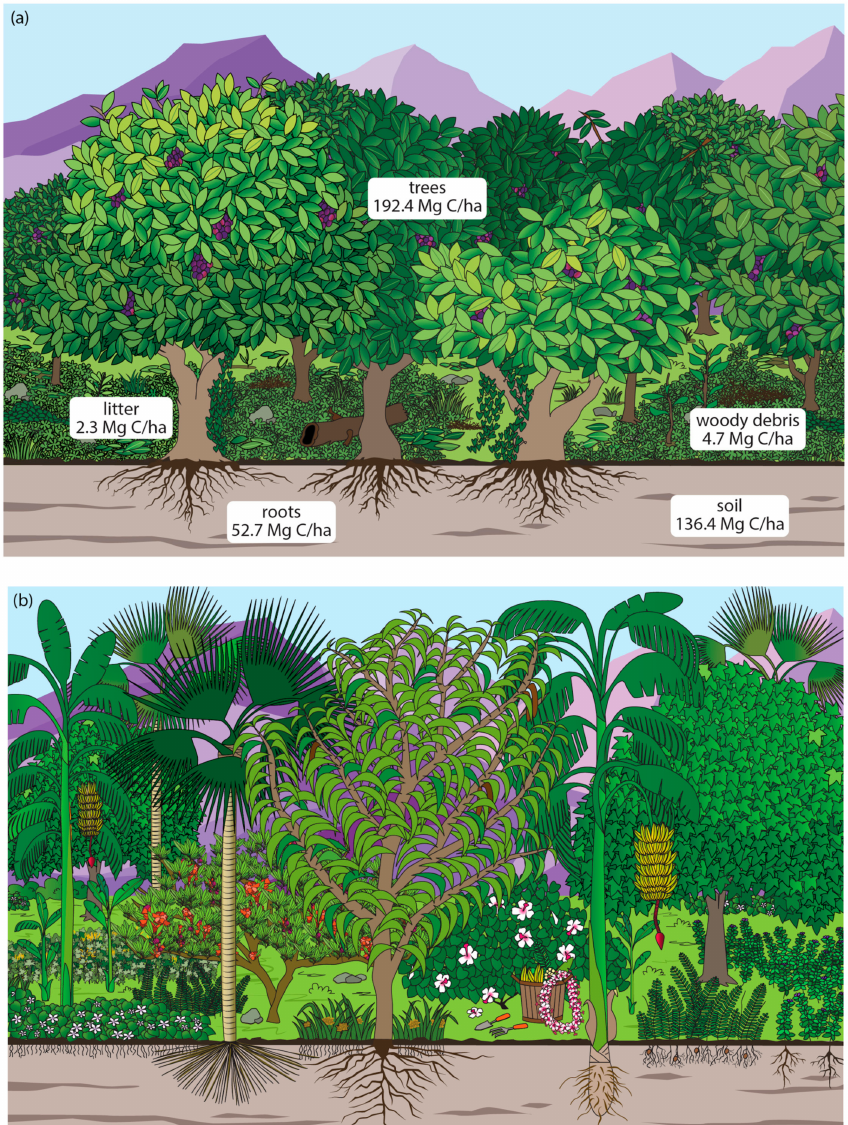
Figure 2. ( a ) Current non-native forest at Pu‘ulani prior to agroforestry restoration along with measured carbon stocks (Mg C/ha) in vegetation and soil. The current forest is dominated by the non-native Java plum ( Syzygium cumini ) tree; ( b ) Envisioned restoration of Pu‘ulani with a diversity of culturally, ecologically, and economically valuable plant species, including overstory and mid-story species: koa ( Acacia koa ), pualoalo ( Hibiscus arnottianus ), loulu ( Prichardia spp.), a‘ali‘i ( Dodonaea vicosa ), kukui ( Aleurites moluccanus ), iholena lele ( Musa spp.) a Hawaiian variety of banana, as well as a variety of understory species including ilie‘e ( Plumbago zeylanica ), pohinahina ( Vitex rotundifolia ), nanea ( Vigna mariana ), ahu‘awa ( Cyprus javanicus ), and kupukupu ( Nephrolepis cordifolia ) [see Hastings et al. [17] for details on restored